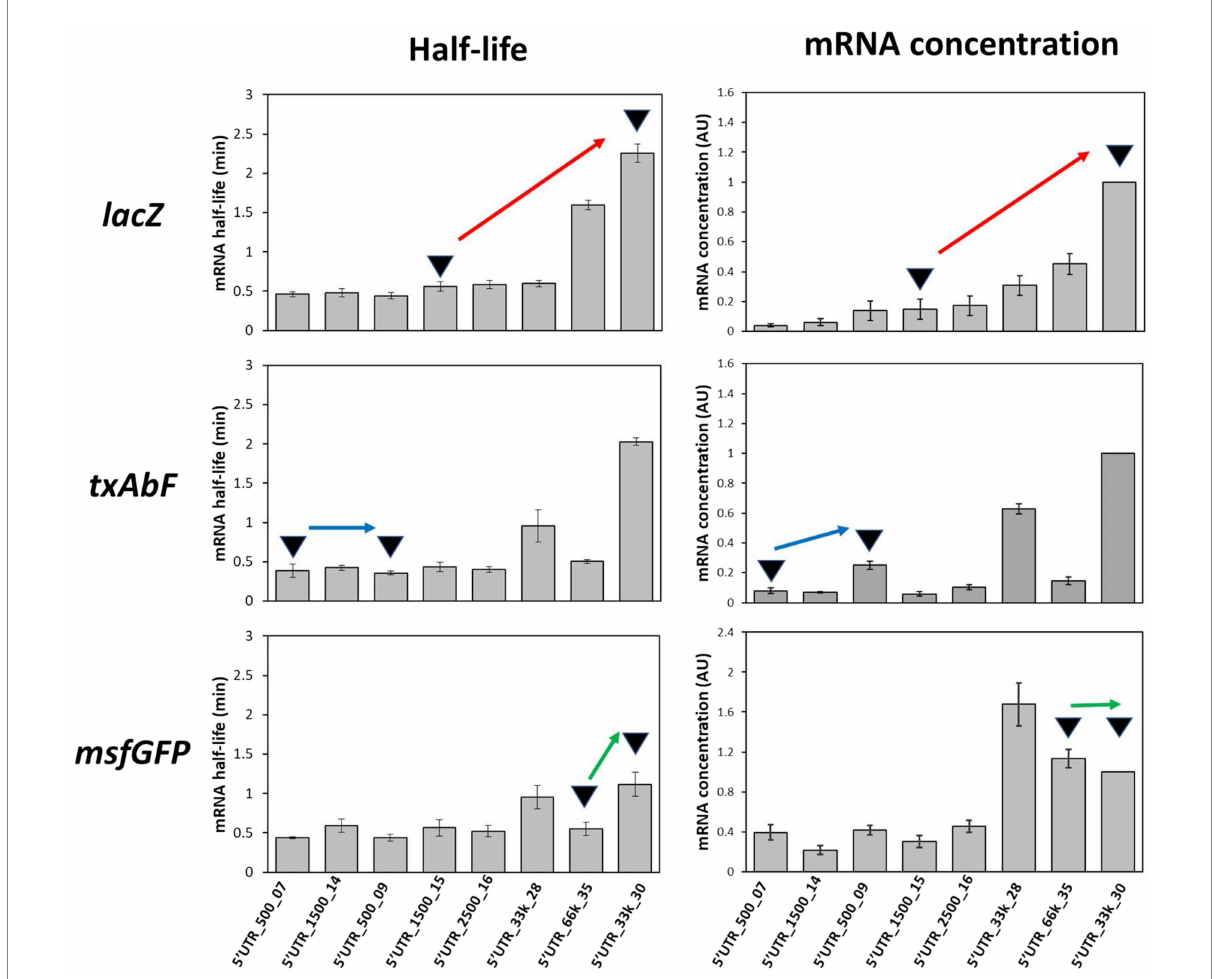
FIGURE 4 Half-lives of mRNAs fused to the eight selected 5’UTRs and graphical interpretation of the effects of the 5’UTRs on mRNA stability and concentration. Red arrow, an increase in mRNA half-life associated with an increase in mRNA concentration; blue arrow, similar mRNA half-lives but an increase in mRNA concentration; green arrow, a longer mRNA half-life not reflected by an increase in mRNA concentration. Error bars represent standard deviations ( n =